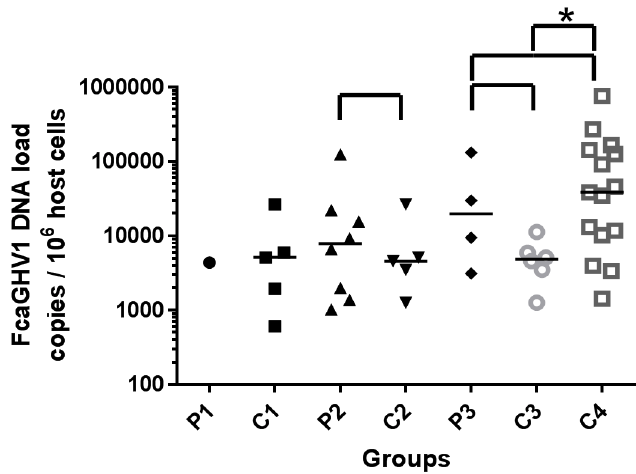
Figure 1. FcaGHV1 viral DNA loads of individuals and median of group (bar). Groups compared statistically shown with bracket. Significant difference highlighted by *.